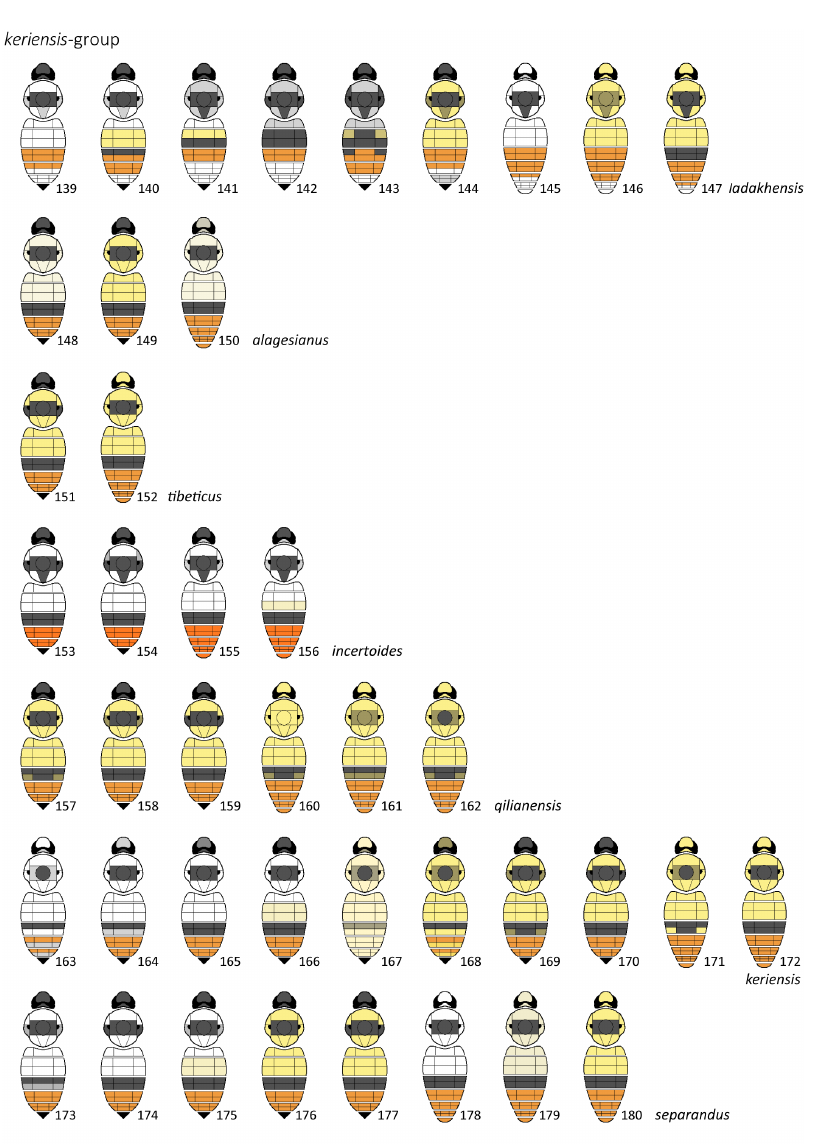
Figs 139–180. Simplified diagrams for the colour patterns of the hair on the dorsum for the species from the integrative analysis. The dorsum is divided into regions, each of which shows only the predominant or most apparent colour for that region using a simplified colour palette, with olive indicating a mixture of black and yellow hair, and grey indicating a mixture of black and white hair. The keriensis -group